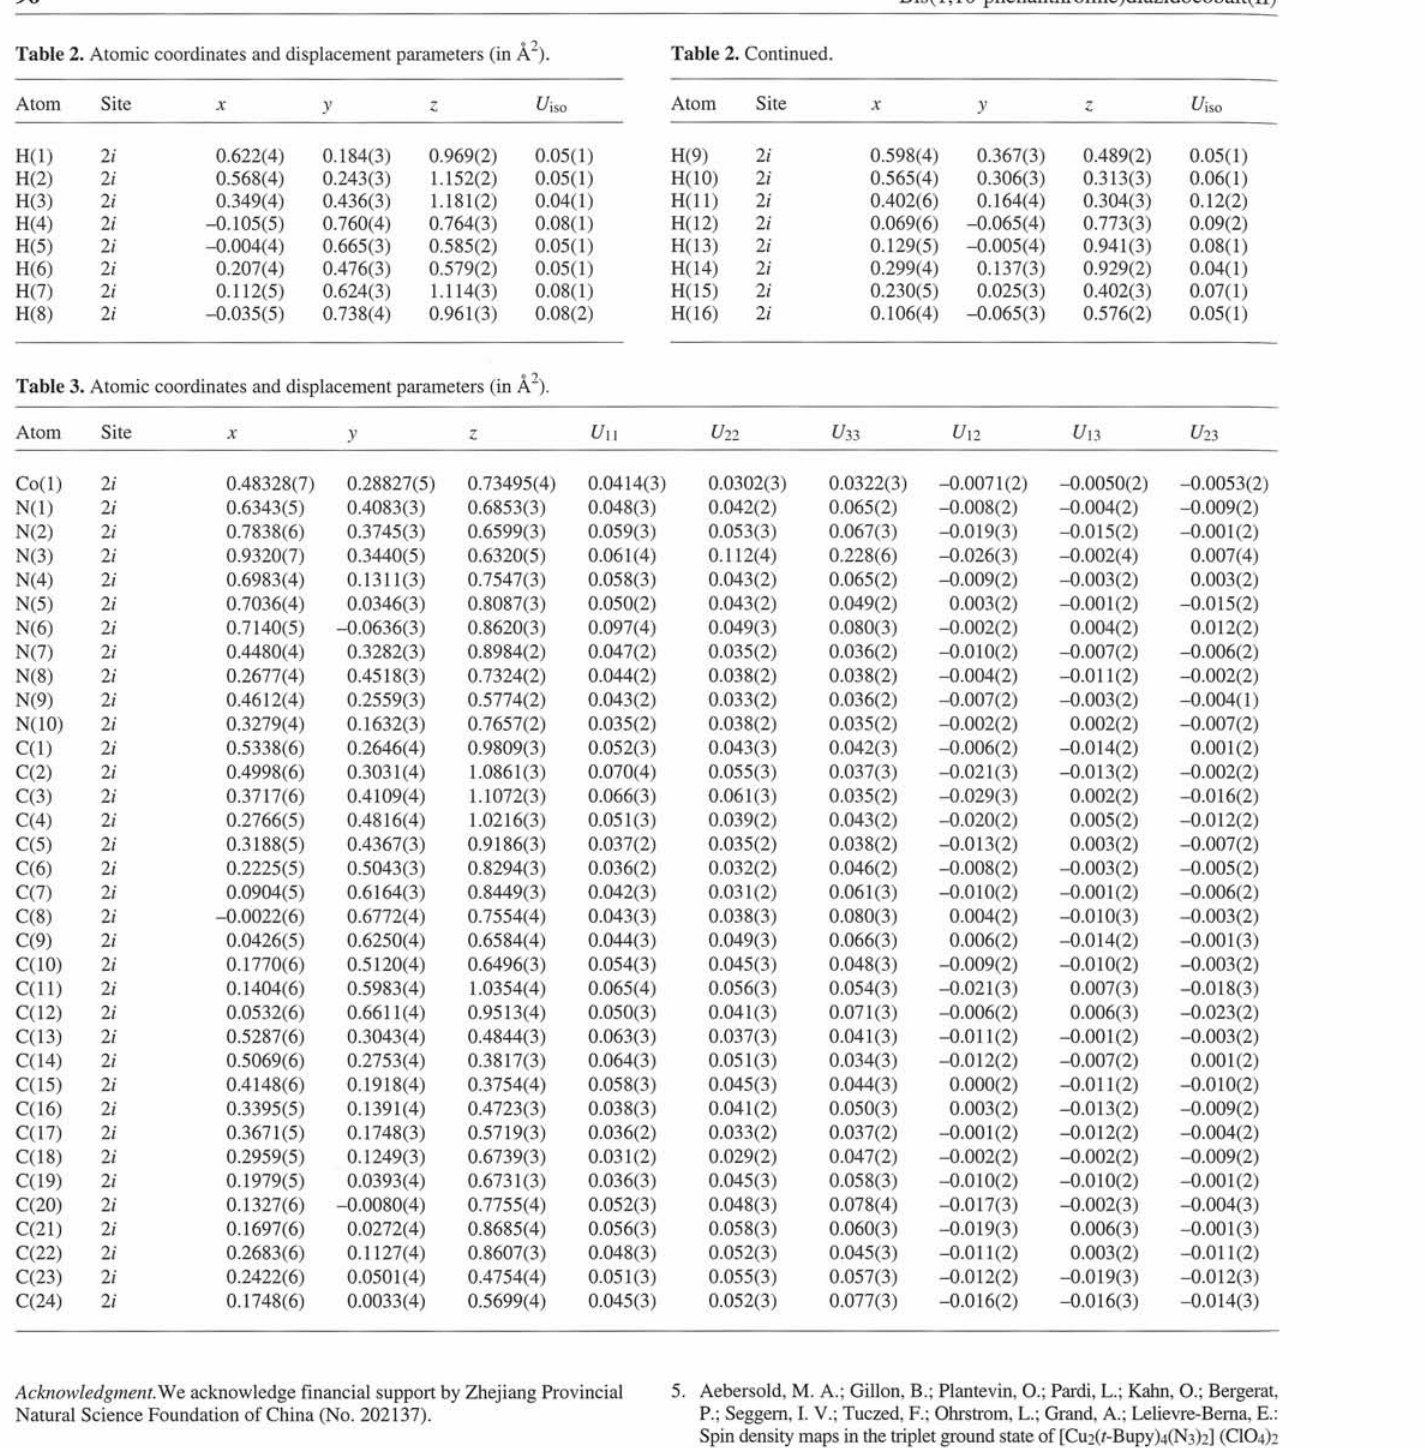
Table 3. Atomic coordinates and displacement parameters (in